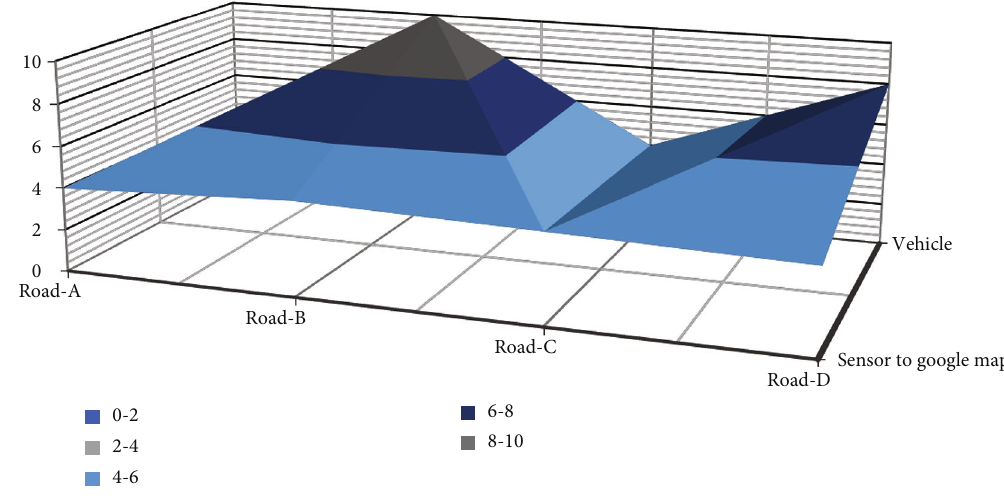
Figure 8: Vehicle vs sync time(s) (sensor to Google Map).